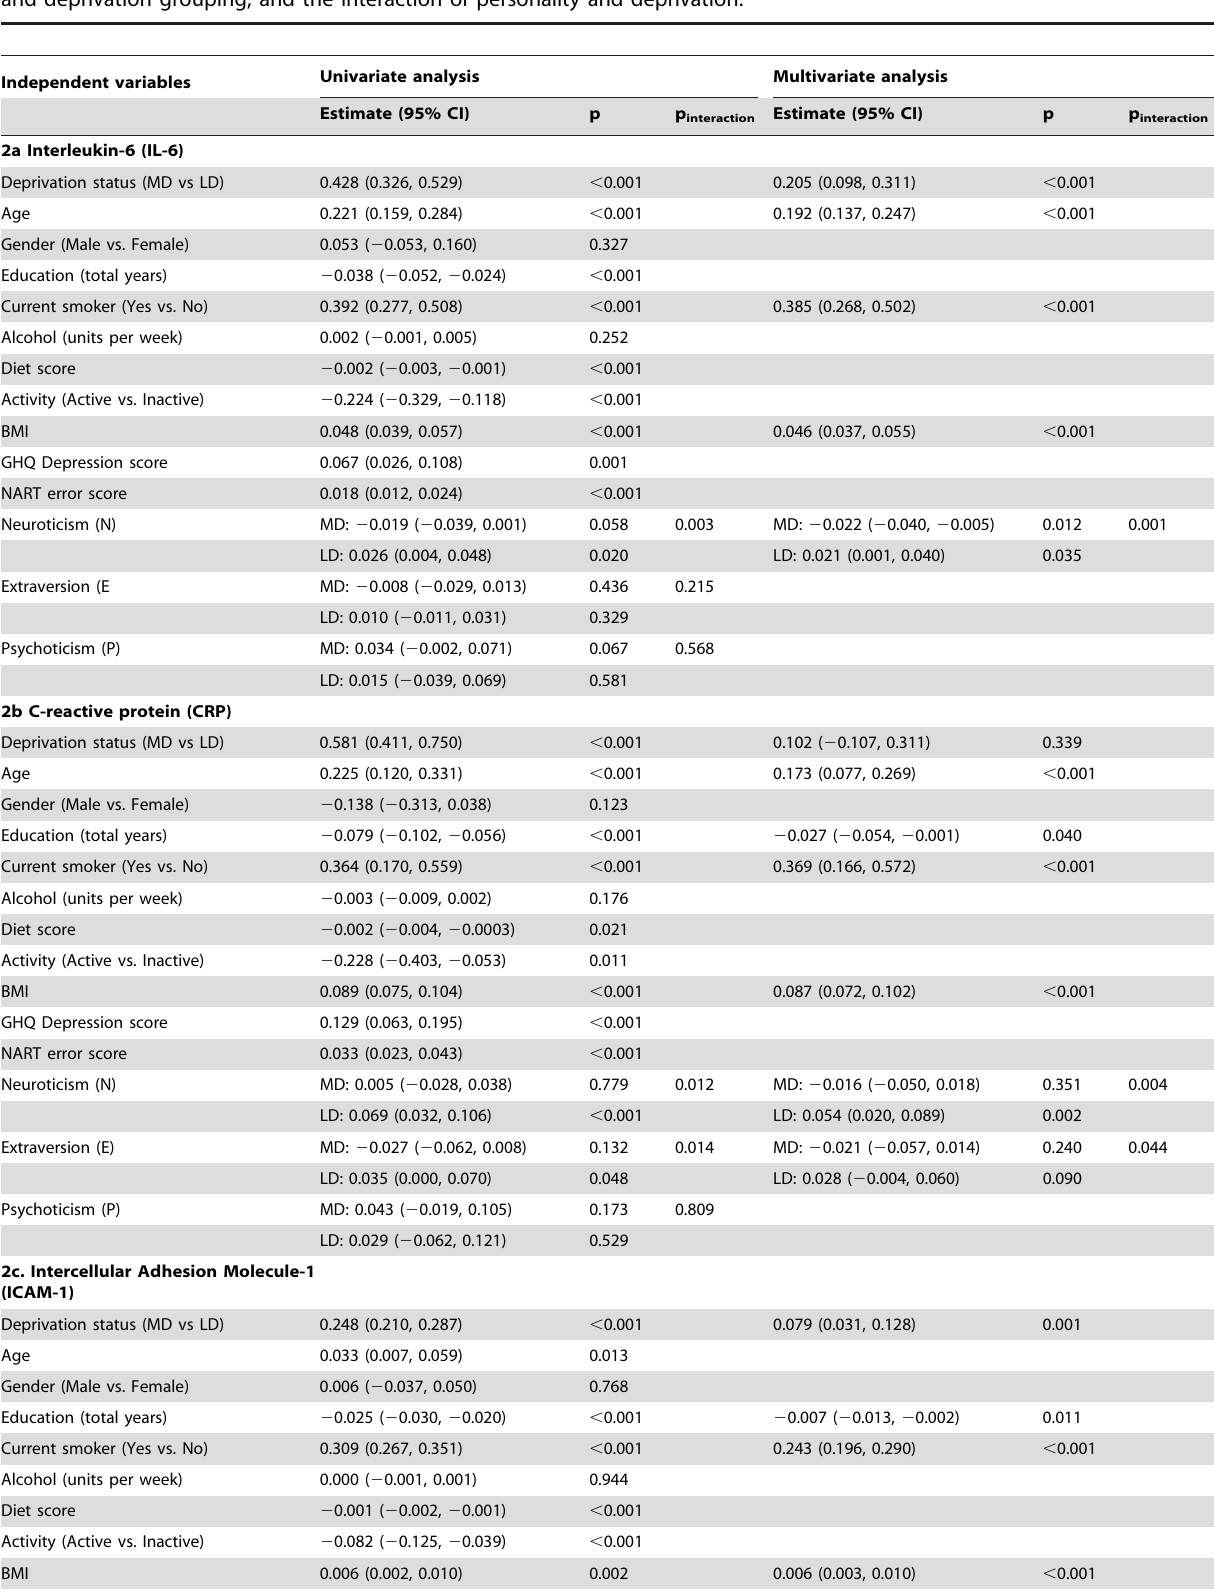
Table 2. Univariate and multivariate associations between inflammatory markers and health-related variables, personality traits and deprivation grouping, and the interaction of personality and